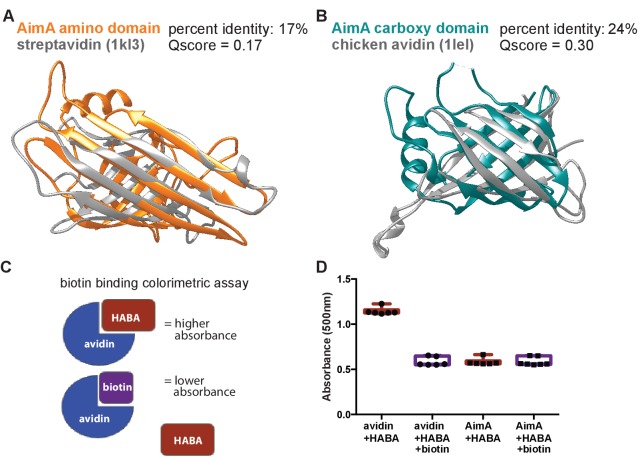
Structural homology of the two domains of AimA to avidins.(A) Structural overlay of N-term domain of AimA with top structural homology hit from PDBeFold search (Supplemental Table 2), Streptomyces avindinii streptavidin (PDB ID 1KL3). (B) Structural overlay of C-term domain of AimA with top structural homology hit from PDBeFold search (Supplemental Table 2), Gallus gallus avidin (PDB ID 1LEL). (C) Schematic of the biotin binding colorimetric assay. Biotin has higher affinity for avidins than HABA does, so it replaces HABA in the binding site, thereby decreasing the absorbance at 500 nm. (D) Results from the biotin binding colorimetric assay. Biotin replaces HABA binding in avidin, corresponding to a decrease in absorbance when biotin is present. With AimA, there is no difference in absorbance with or without biotin, indicating no biotin binding.